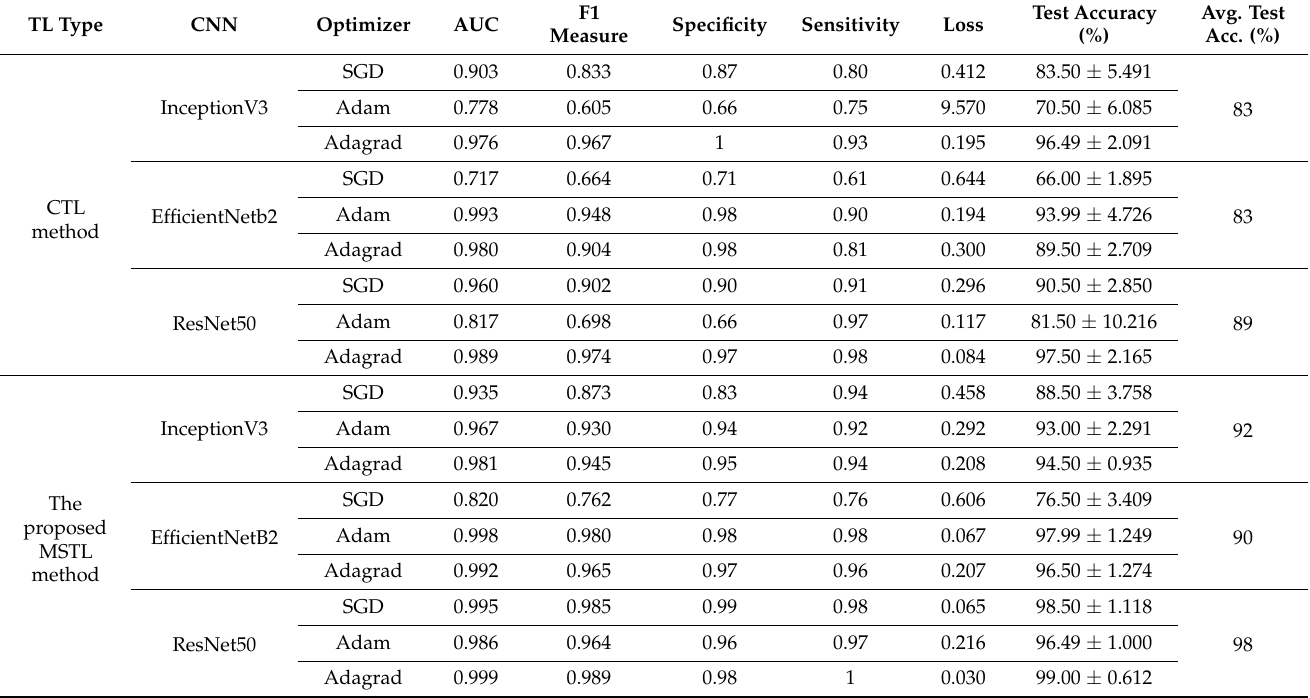
Table 1. The averaged performance results over 5-fold cross validation of the proposed multistage transfer learning and its comparison against conventional transfer learning. TL: transfer learning; CNN: convolutional neural network; AUC: area under ROC curve, Avg.: average; CTL: conventional transfer learning; MSTL: multistage transfer learning; SGD: stochastic gradient